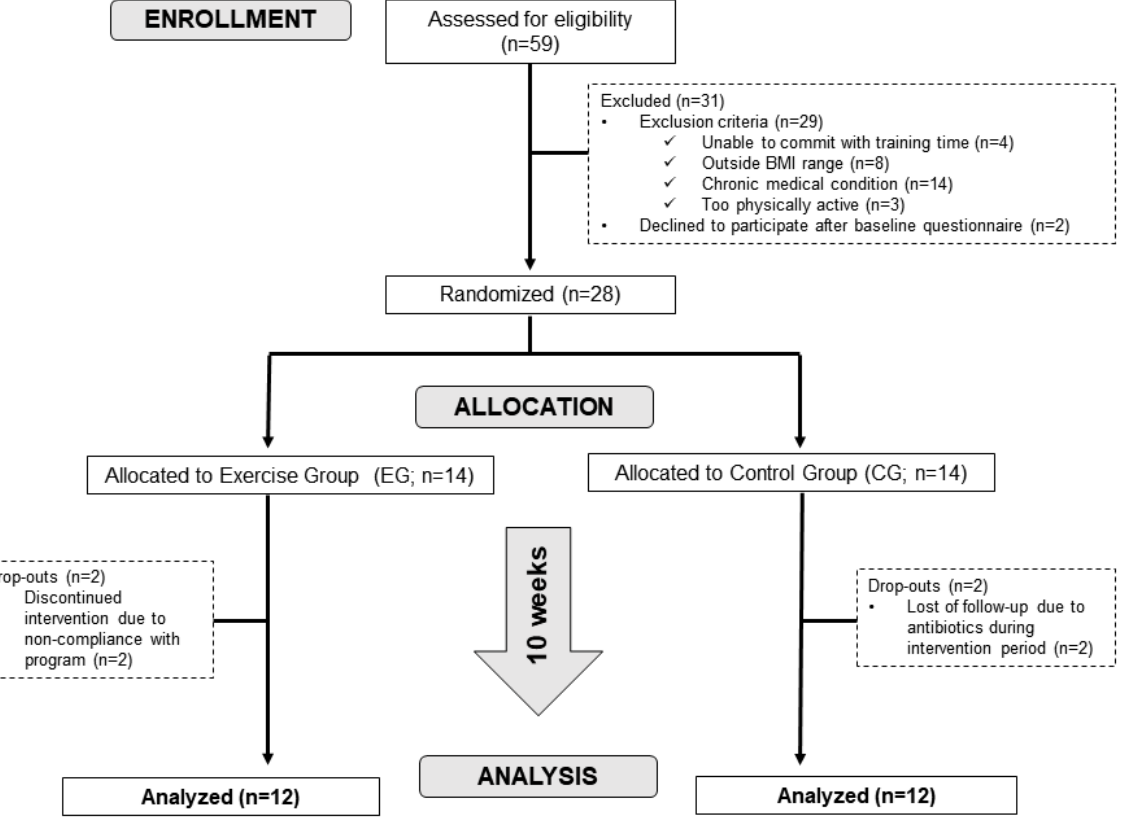
Figure 1. CONSORT Flow